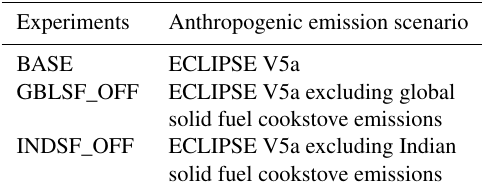
Table 2. Model experiments’ setup.